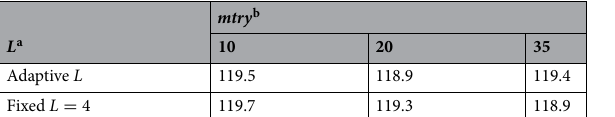
b mtry is the size of the subset